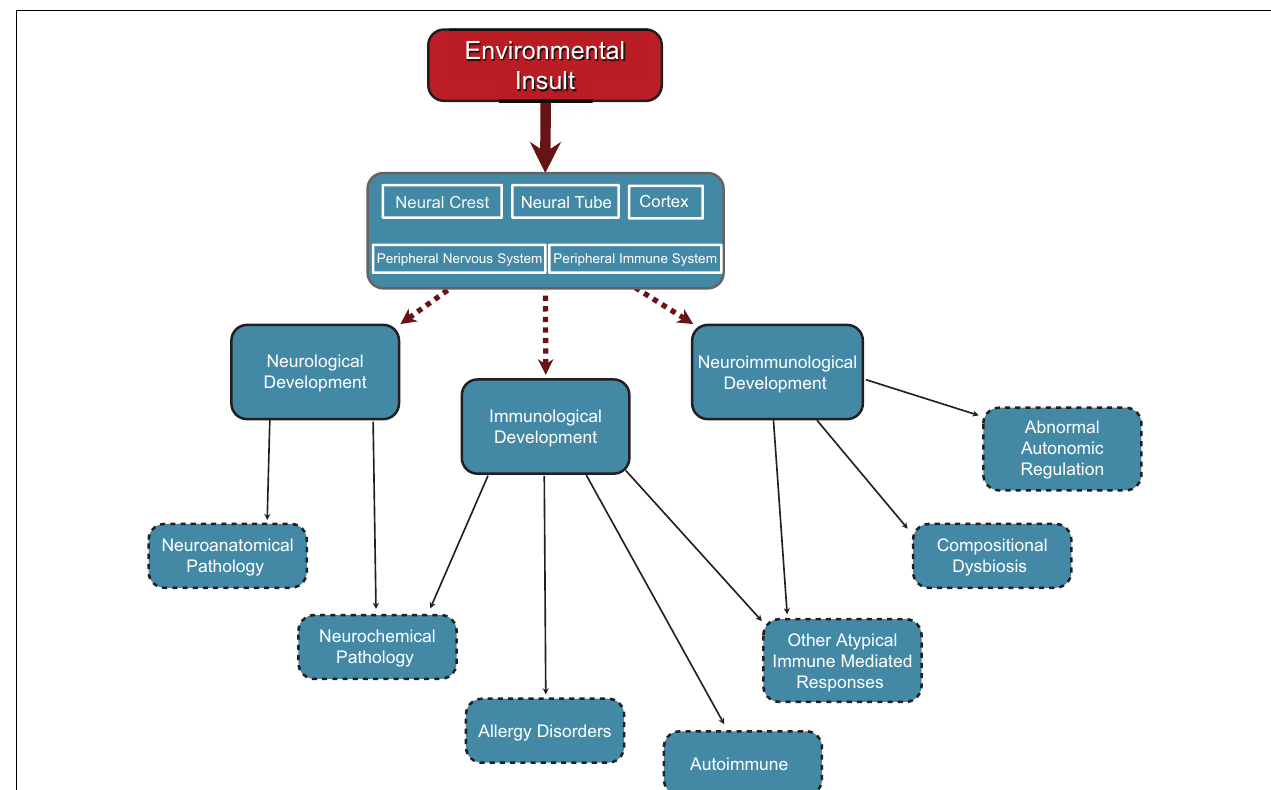
also produce changes in central autonomic functions and/or set points for physiological control systems resident in the hypothalamus and brain stem autonomic nuclei. Factors affecting cortical development would have an impact on higher cortical functions including psychosocial, sensory processing, and motor functioning. Any of these neurodevelopmental effects would have cascading effects through the sensory and neuro-immune pathways to neurological, neuro-immune, and immune